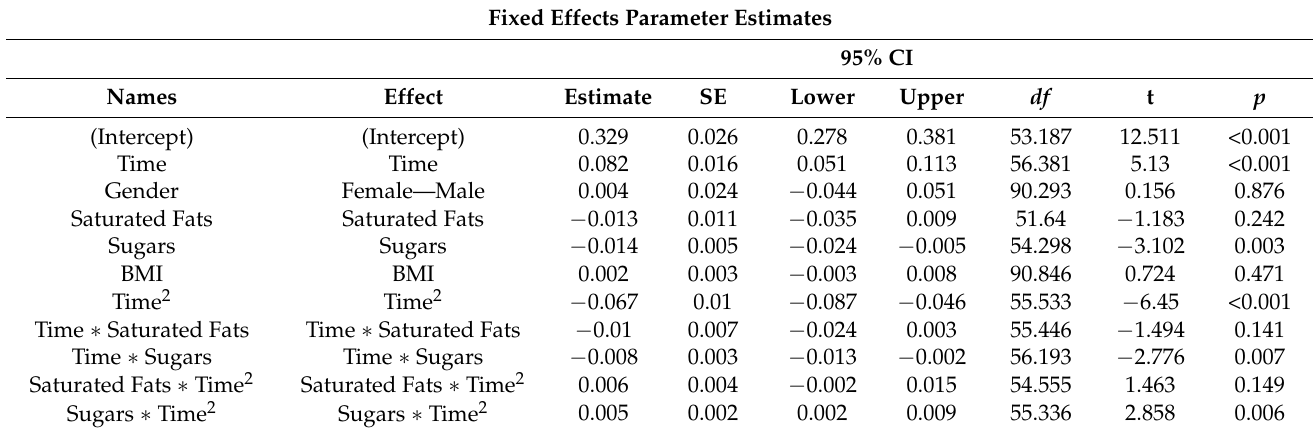
Table 3. Fixed effect parameter estimates for the final model.